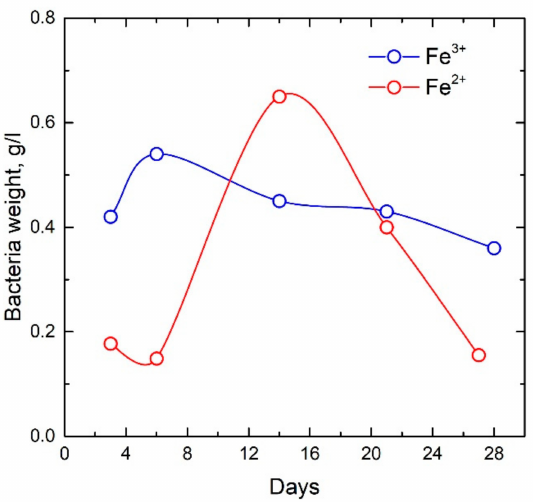
Figure 1. Time dependences of the dry weight of bacteria grown on Fe 2+ oxalate and Fe 3+ citrate. To isolate ferrihydrite from the sediment and obtain a sol, the bacterial biomass was separated from the supernatant by centrifugation (10 min, 10,000 rpm), then the bacteria cells were destroyed by ultrasound (ultrasonic disintegrator UZDN (1 min, 44 kHz, 20 W)) 3 times for 3 min in distilled water at intervals of 10 min. Next, the resulting precipitate to remove fatty acids was sonicated and incubated in acetone for 30 min and washed with distilled water (sonication, centrifugation). Then, the precipitate was placed in a 2% NaOH solution, the incubation time was 1 h. The resulting precipitate was washed with distilled water with the addition of NaCl (sonication, centrifugation) until a pH of 8 supernatant was reached. Thus, a sol was obtained, which was subsequently dried at room